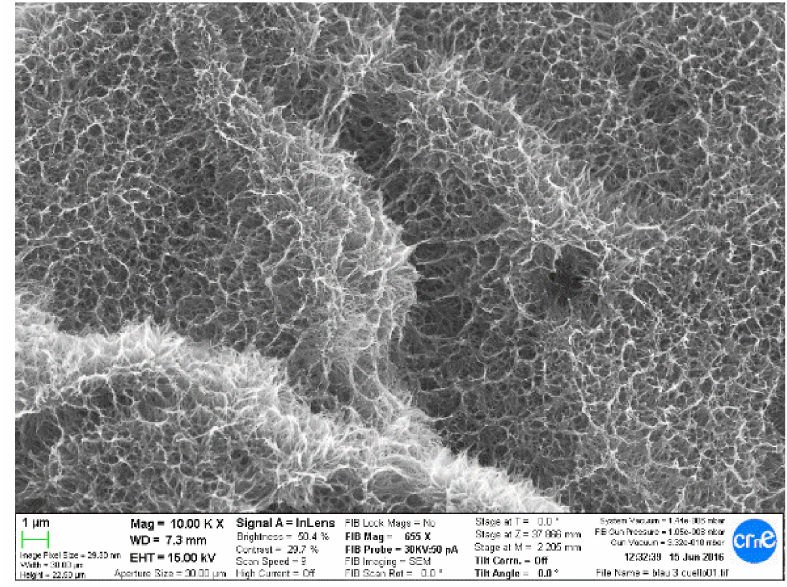
Figure 3. Titanate gel on a titanium